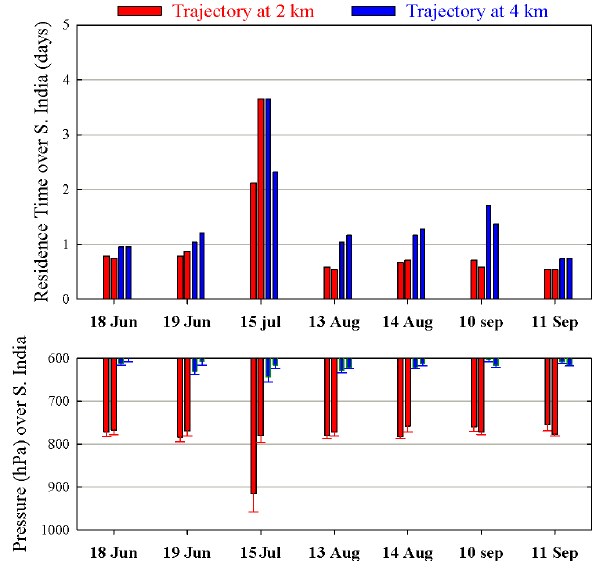
Figure 12. Residence time of air masses over the southern Indian re- gion on all CARIBIC measurement days calculated from the back- trajectories at 2 and 4km above Chennai. The mean pressure along the trajectory over southern India is also